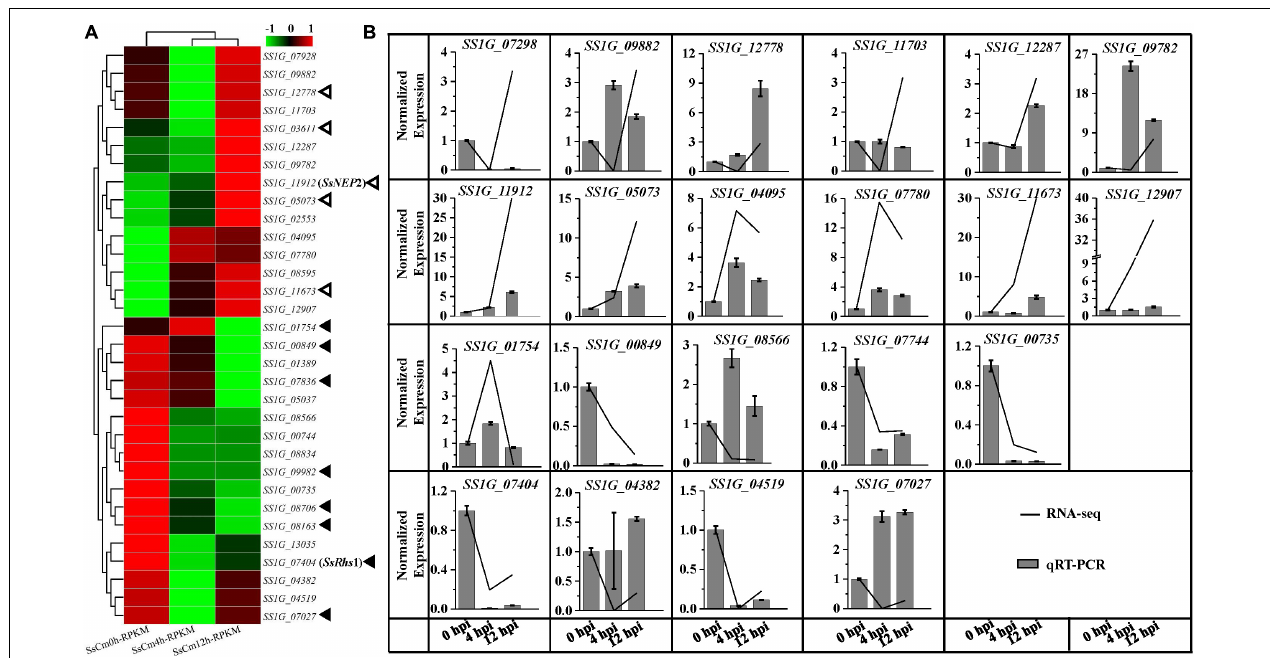
FIGURE 5 | Comparsion of RNA-seq and qRT-PCR results for the relative expression of predicted effector encoding genes at 0, 4, 12 hpi of S. sclerotiorum induced by C. minitans . (A) Gene expression of the 32 detected effector encoding gene of S. sclerotiorum during the early parasitized stages of S. sclerotiorum using RNA sequencing. Hollow triangles represent the five DEGs with similar gene patterns to pathogenic process; the solid black triangles indicate the eight DEGs with different patterns in parasitism process from pathogenic process. (B) Verification of 12 significantly up-regulated and 8 down-regulated effector encoding genes of S. sclerotiorum using qRT-PCR. The gene changes in transcript abundance of RNA-seq were normalized with RPKM, and for the qRT-PCR, all the data were normalized against the expression of the β -tubulin gene and the gene expression at 0 hpi was set control as 1. The related primer pairs were listed in Supplementary Table S7